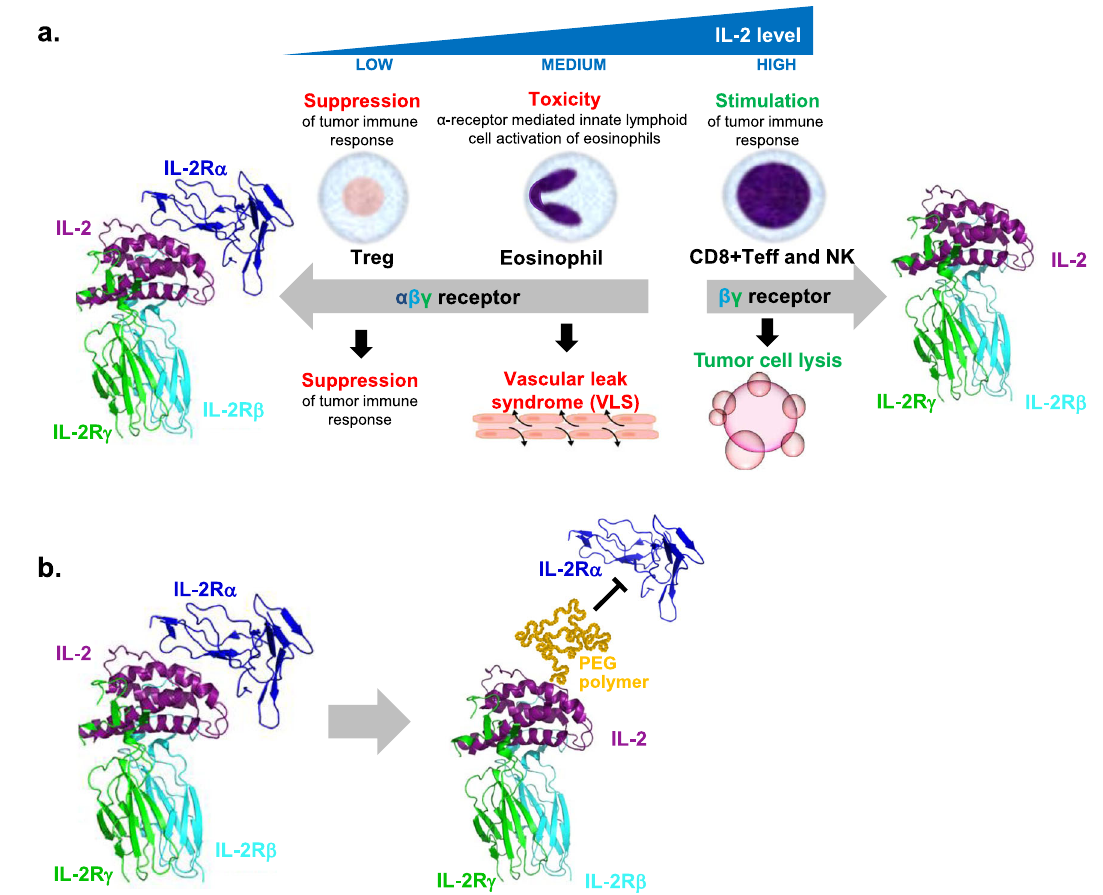
Fig. 2 Overview of IL-2 pharmacology and therapeutic hypothesis of pegylated IL-2 with “ not alpha ” receptor speci fi city. a Schematic depicting IL-2 receptor biology, highlighting the desired and undesired effects of IL-2 therapy. To stimulate anti-tumor responses, high IL-2 (purple chain) concentrations are required to agonize the IL-2R βγ complex (cyan and green chains) on CD8 + T and NK cells, driving activation and proliferation needed for tumor destruction. However, immune cell types with undesired biological activities also express the IL-2R α chain, allowing their response to lower IL-2 concentrations. This results in Treg-mediated suppression of effector T cell populations, or stimulation of ILC-2 cells (not shown), which release IL-5 to drive VLS indirectly via eosinophil activation 9 . Therefore, the high rhIL-2 concentrations required to drive ef fi cacy also result in Treg activation and toxicity in an IL-2R α dependent manner. Blocking engagement of IL-2R α may provide an improved therapy with reduced undesired target activation. b Concept of a site-speci fi c PEG-modi fi ed “ not alpha ” IL-2, in which PEG attachment at the IL-2R α interface blocks IL-2R α engagement. The resulting compound allows normal IL-2R βγ signaling and extends half-life via increased molecular size (not shown). Schematic of IL-2 (left) and THOR-707 (right) binding to the IL-2 receptor complex. Human IL-2 (purple chain) forms a heterotrimeric complex with the IL-2 receptor β (cyan), γ (green) and α (blue) subunits. Site-speci fi c PEG modi fi cation (orange polymer) of THOR-707 at the IL-2 R α receptor interface allows targeted reduction of the IL-2 R α engagement without speci fi c reduction in the engagement of the IL-2 R βγ